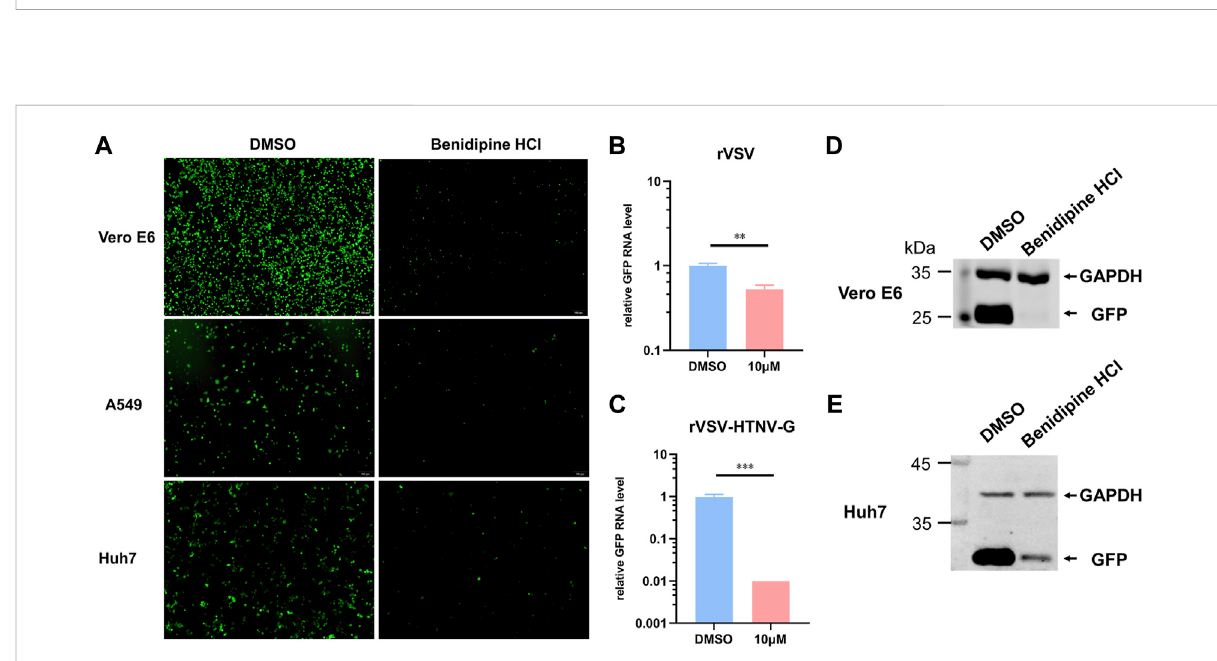
FIGURE 3 EffectofbenidipinehydrochlorideontheentrystagesofHTNV. (A) VeroE6,A549,andHuh7cellsweretreatedwithbenidipinehydrochlorideor the DMSO vehicle and then inoculated with rVSV-HTNV-G at MOI 1, and GFP-positive cells were photographed 24 h after infection. (B,C) Vero E6 cells were treated with benidipine hydrochloride or the DMSO vehicle and then infected with rVSV (B) or rVSV-HTNV-G (C) . After 24 h post- infection, total RNA was extracted, and GFP RNA levels were determined by qRT-PCR and normalized to GAPDH. (D, E) Vero (D) and Huh7 (E) cells were treated with 10 μ M benidipine hydrochloride and infected with rVSV-HTNV-G; the cells were lysed 24 h after infection and blotted with antibodies against GFP and GAPDH. ** p < 0.01; *** p <